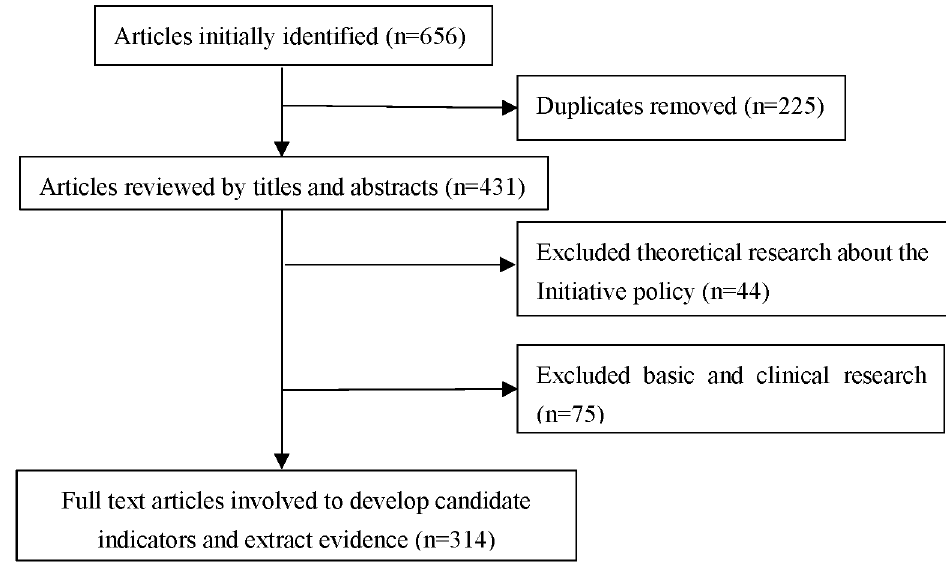
Fig 1. Flowchart of article